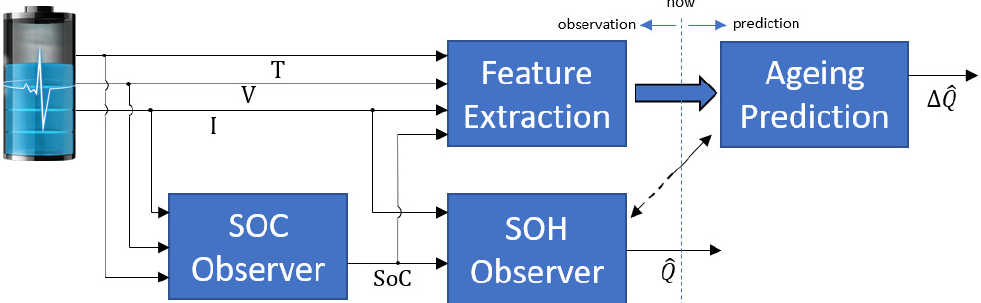
Figure 1. A block diagram of the state estimation and ageing prediction structure.